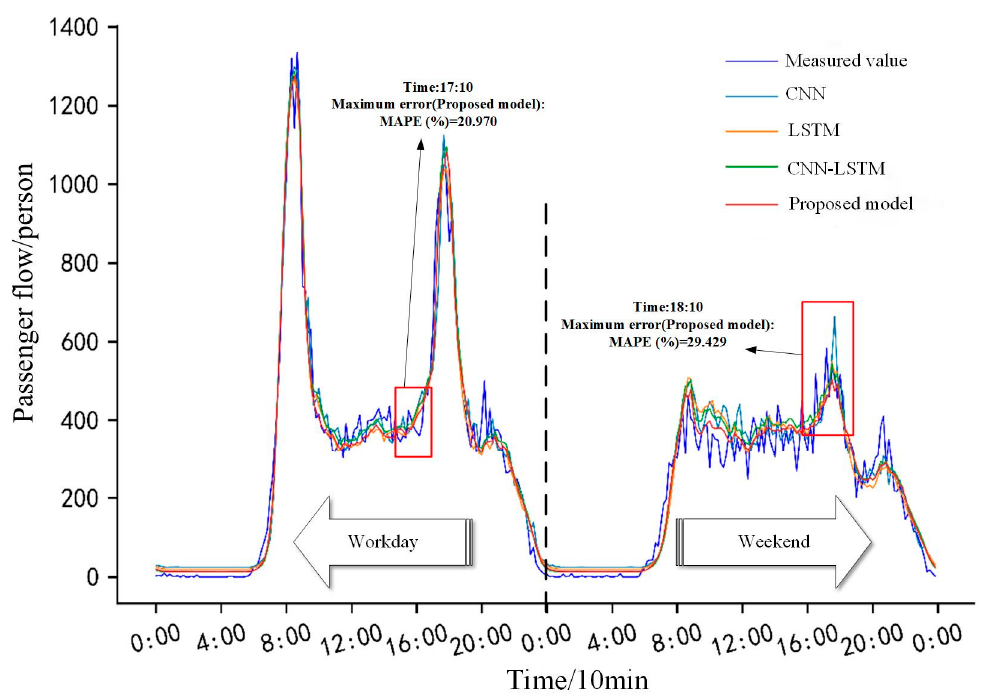
Figure 11. Comparison of passenger flow prediction of different models at Jinjiang Station.